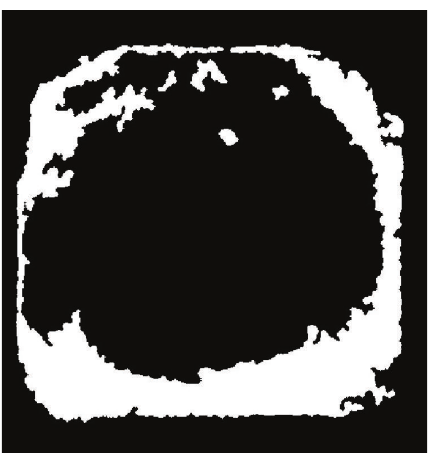
Figure 8: Connecting the segmented